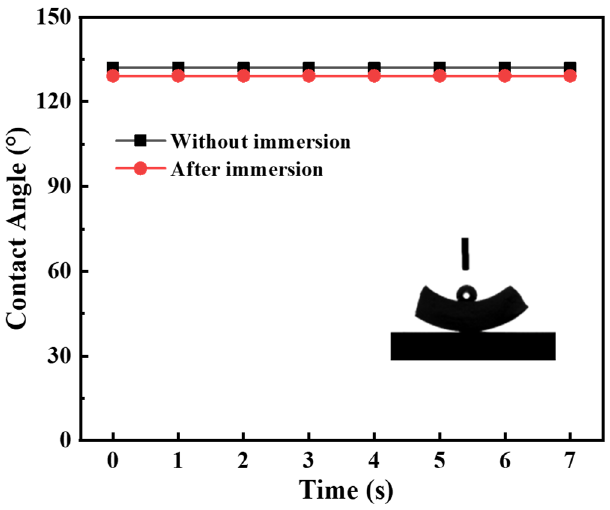
Figure 12. The water contact angle of the ceramic membrane after 30 day of immersion.